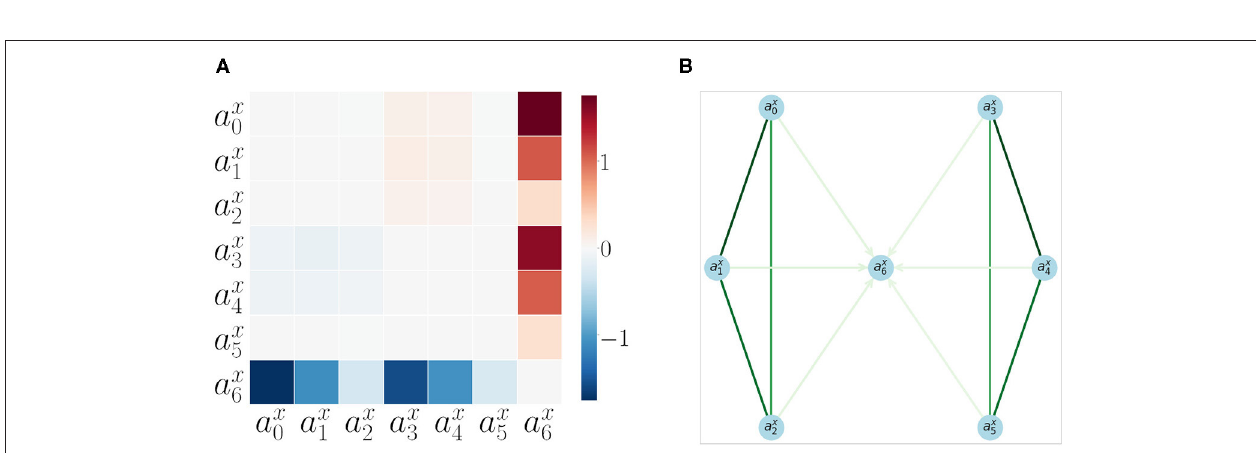
FIGURE 5 | Acceleration Transfer measure. We plot an example of the AT measure (shaded area in red) due to a contact of the lower arm (sensory point s 0 , with corresponding acceleration a x 0 ) with the object (sensory point s 6 , with corresponding acceleration a x 6 ). At the beginning of the contact, the arm loses acceleration rapidly which is transferred to the object. After some time steps (after time step 10), both start to couple and synchronize.